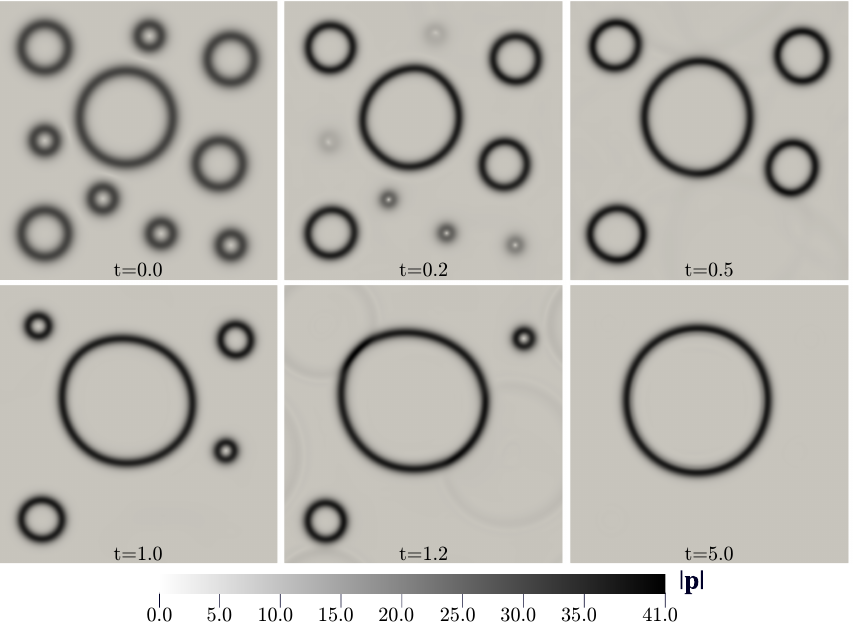
Figure 11. Numerical result for the magnitude of the gradient field p for the same simulation as in Figure 10.